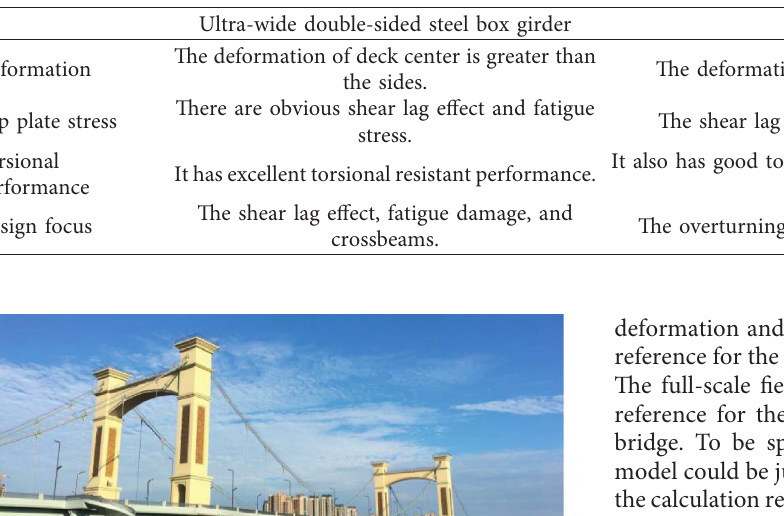
Table 1: The differences between the ultra-wide double-sided steel box girders and common box girders.